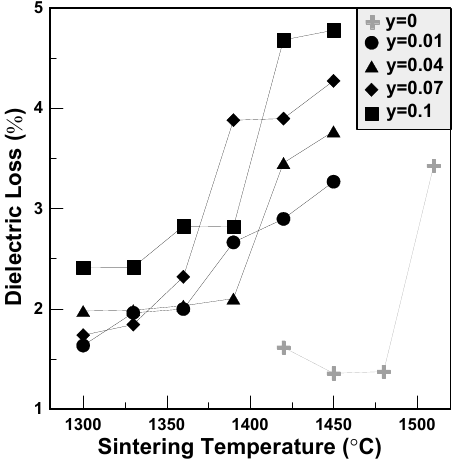
Figure 5. The dielectric loss of the BCTS–yLiF sheets.